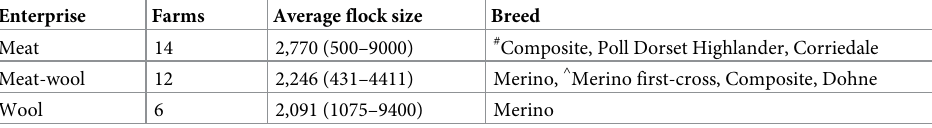
Table 3. Farm demographics according to enterprise, flock size and breed. The range of the ewe flock sizes is pre- sented in parentheses. Enterprise